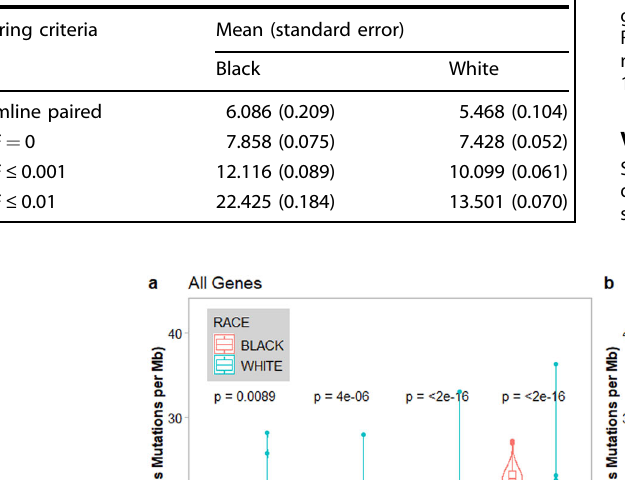
Table 1. TMB (mutations/Mb) estimate in patients using different criteria of non-somatic variant fi ltering.